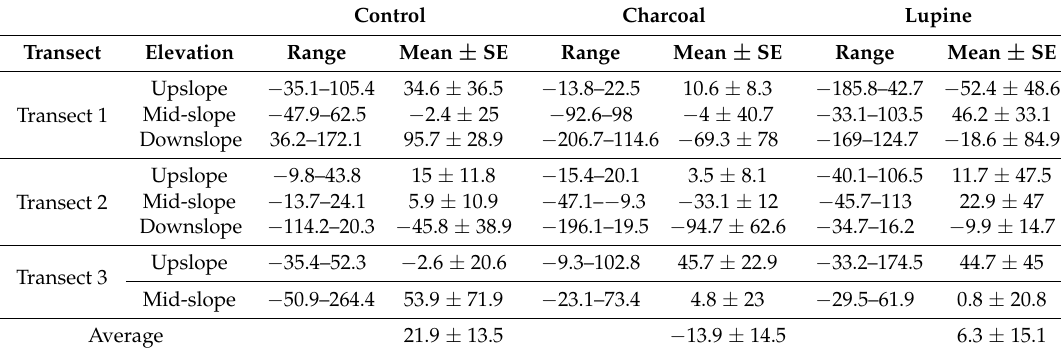
Figure 6. Distribution of observed methane emissions from 24 static chambers installed along the slope catena in three transects based on combined data from all campaigns. Table 3. Summary, range (minimum and maximum) and mean ± standard error (SE) of means, of methane emissions along the slope catena of three transects based on combined data from all campaigns. Control